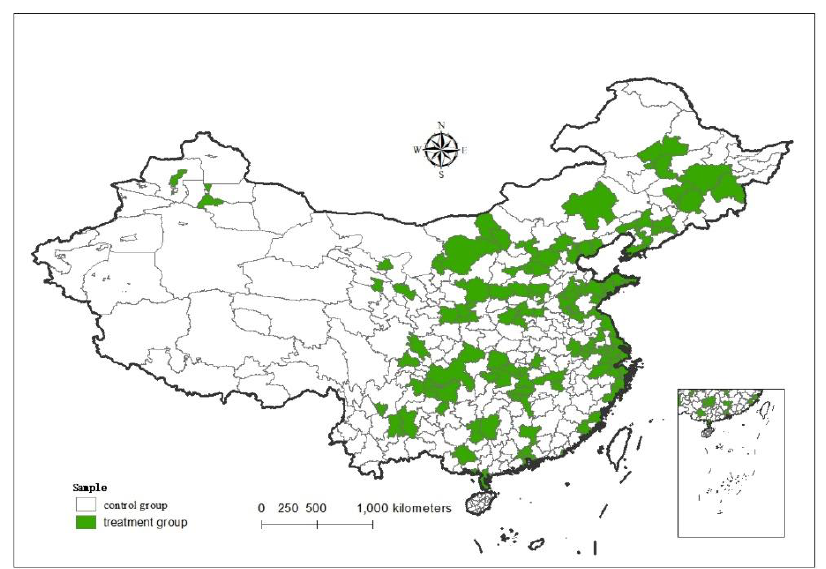
Figure 1. Spatial distribution of environmental information disclosure pilot areas in China.